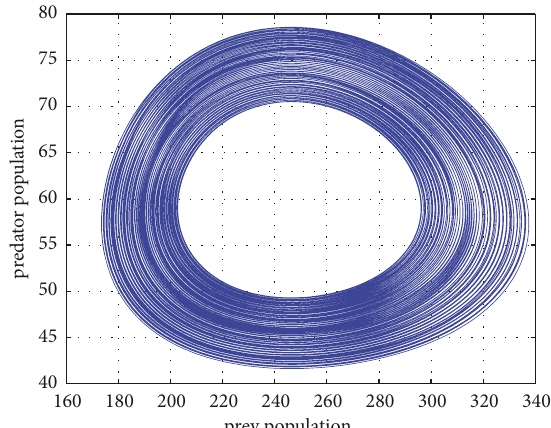
Figure 2: The phase portrait of model (2) with weak Allee effect. The parameters are taken as 𝐴 = 0.01 , 𝑟 = 2.65 , 𝐾 = 900 , 𝑎 = 0.02 , 𝑐 = 0.215 , and 𝑚 = 1.06 ; 𝐸 stable.